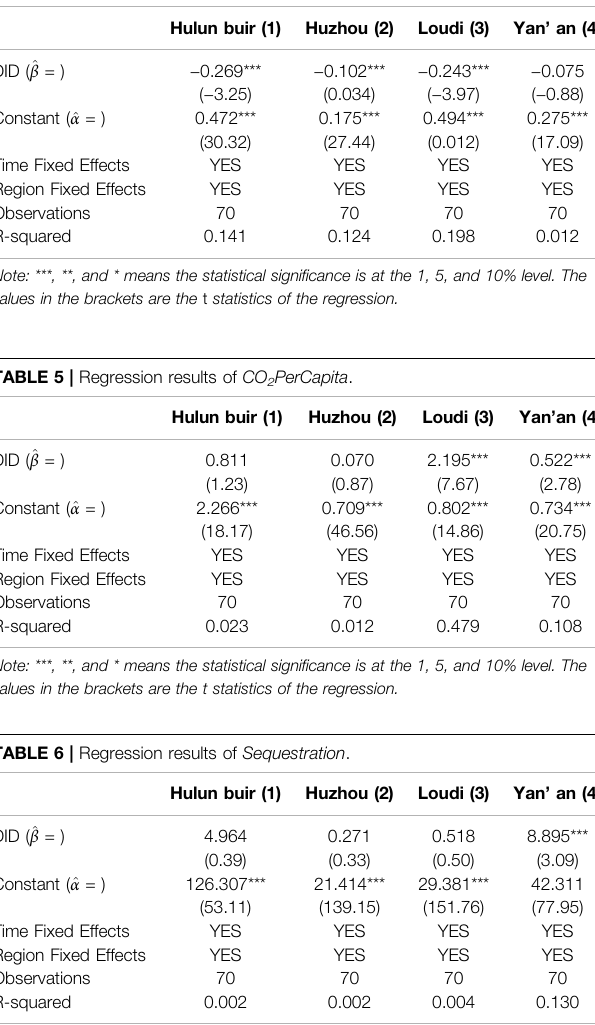
TABLE 3 | Descriptive statistics of variables. TABLE 4 | Regression results of CO 2 PerGDP .